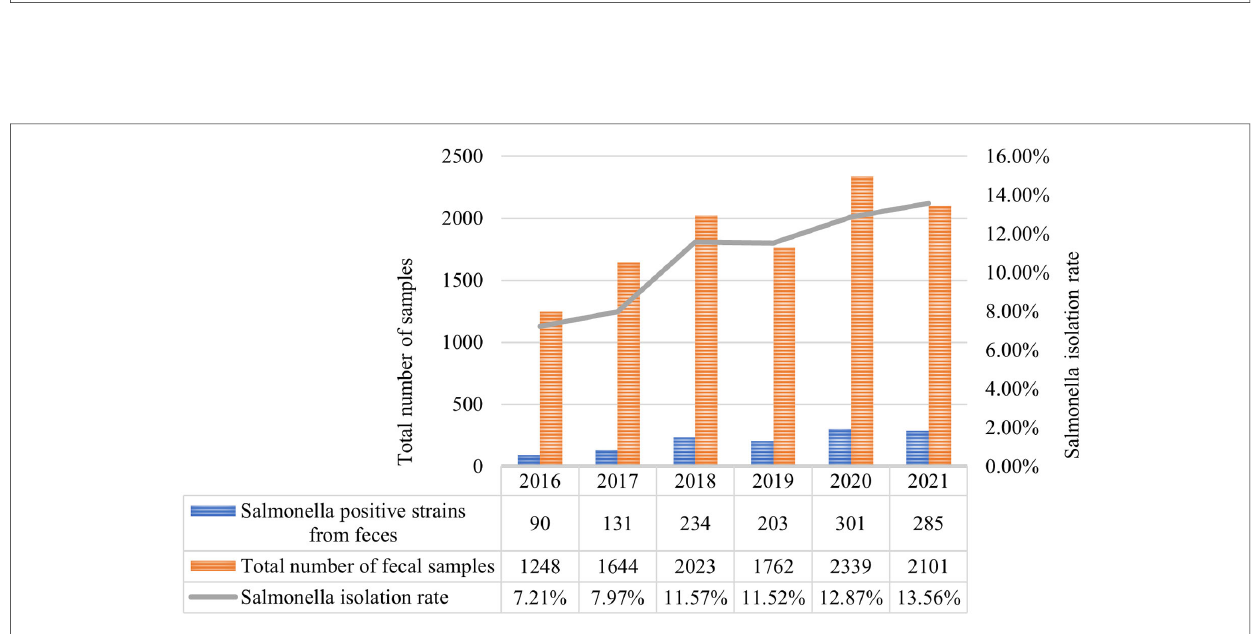
FIGURE 2 Annual distribution of Salmonella isolated from feces from 2016 to 2021. The bar chart represents the total number of fecal samples and Salmonella positive strains from feces. The Salmonella isolation rate of 6 years is shown in the line graph. Salmonella exhibited an increasing trend year by